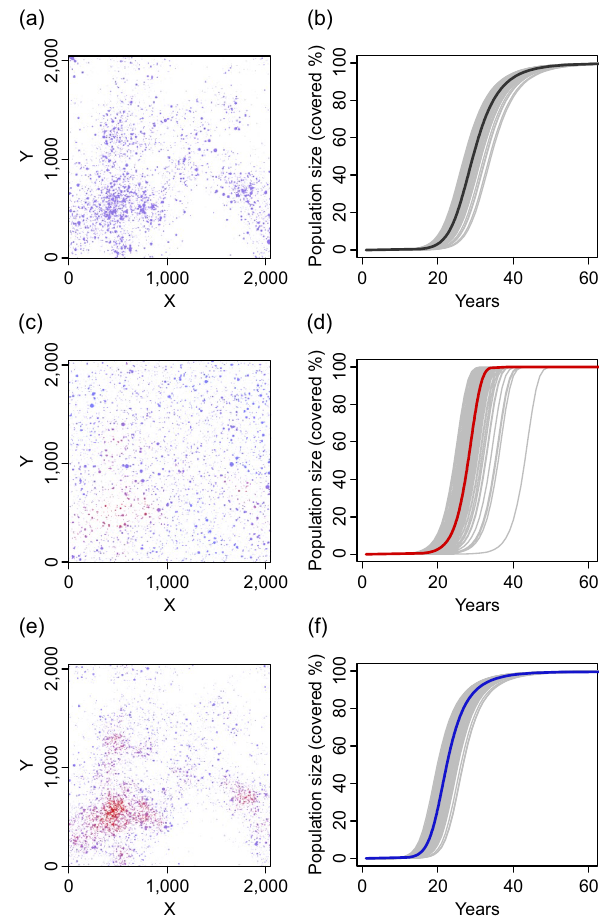
Figure 1. Spatial settings influence realized spatial distributions of colonies and their population dynamics: ( a , b ) destination-mediated-dispersal model, ( c , d ) source-mediated-dispersal model, and ( e , f ) source–destination- mediated-dispersal model. ( a , c , e ) Colored regions show colonies that cover 10% of the entire area (ages of these populations are 28, 35, and 18, respectively). Colors of these regions indicate colonies with low (blue) to high (red) dispersal frequencies. White to gray shades indicate the magnitude of the background intensity distribution (darker for larger intensities). ( b , d , f ) Thin gray curves indicate 100 independent time courses for proportions of areas occupied by colonies. Thick curves show the average time in which a population reaches 1 a certain proportion. All realizations, including realizations for panels ( a , c , and e ), use the same background 3 = 1.40 intensity distribution ( F h